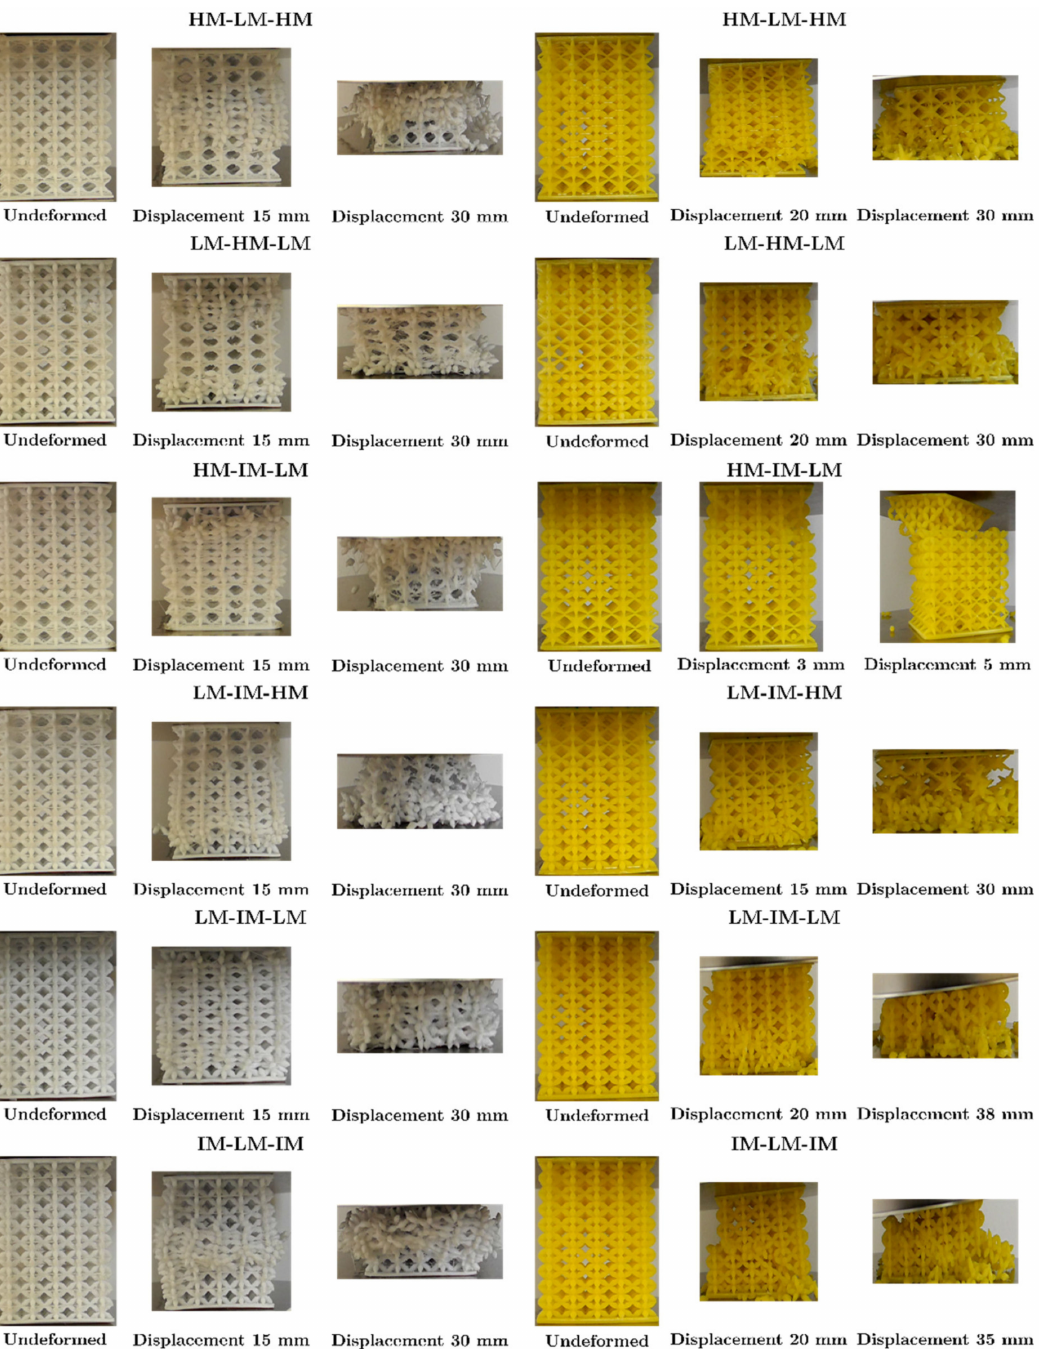
Figure 21. Deformed shape in a compression test. Left: lattice structures with PLA Right: lattice structures with